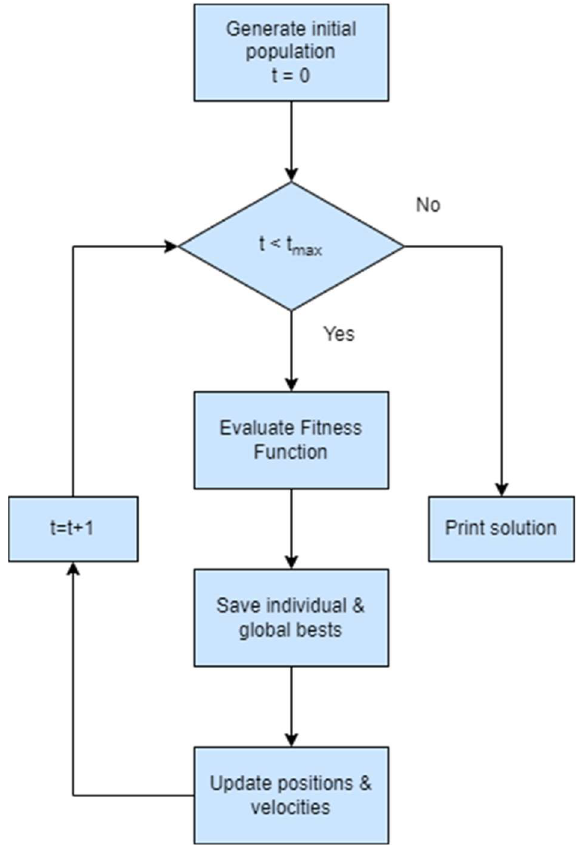
Figure 2. Outline of